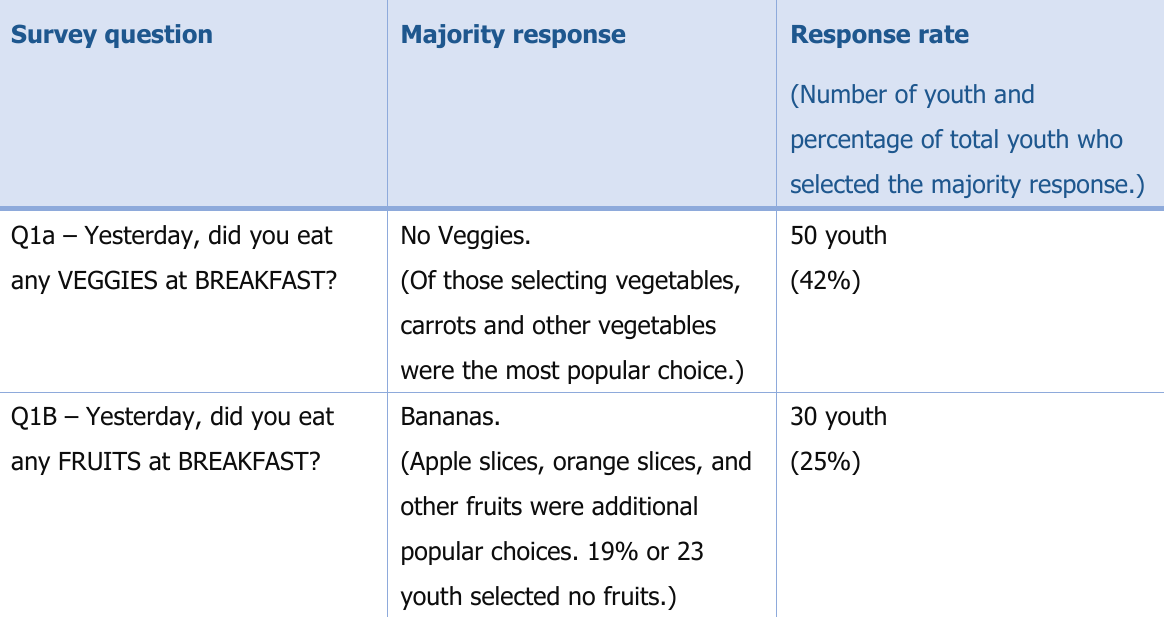
Table 1. Responses to Questions on Fruit and Vegetable Consumption at Breakfast from a Sample CHAT